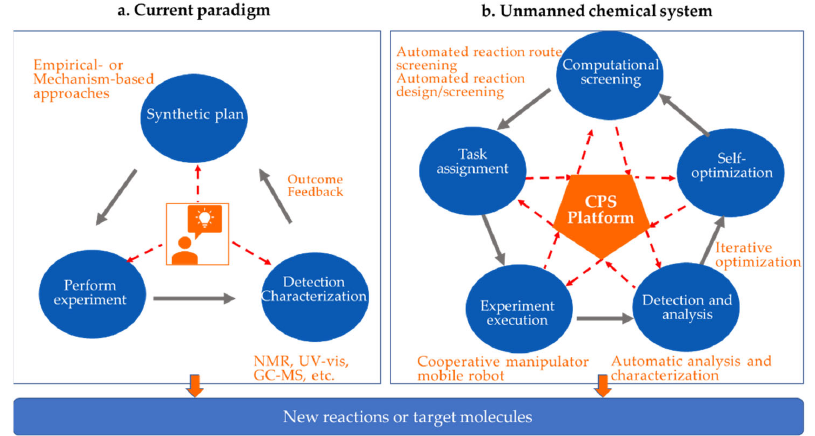
Figure 1. Schematic comparison of chemical synthesis paradigms. ( a ) The current paradigm; ( b ) reaction discovery or molecule synthesis with unmanned chemical systems integrated by the CPS (cyber-physical system) platform.